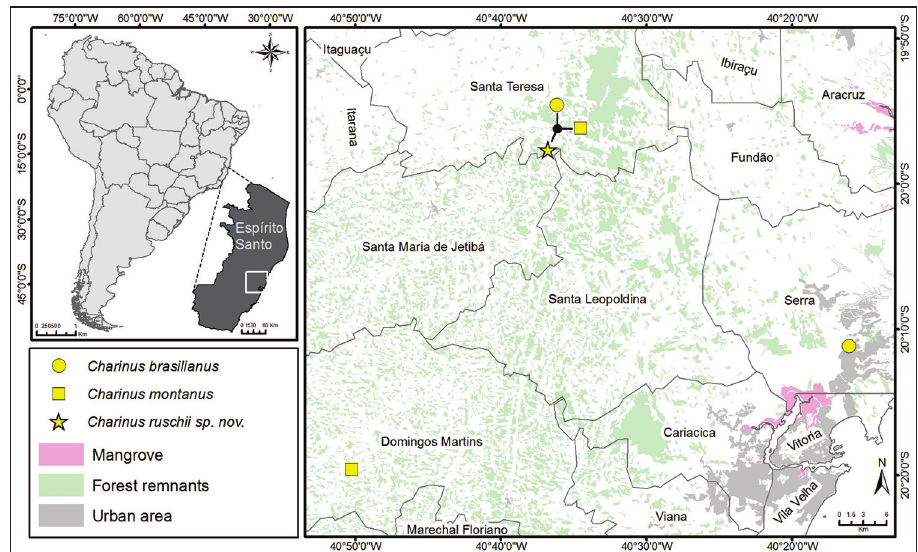
Figure 4. Distribution map of Charinus in the state of Espírito